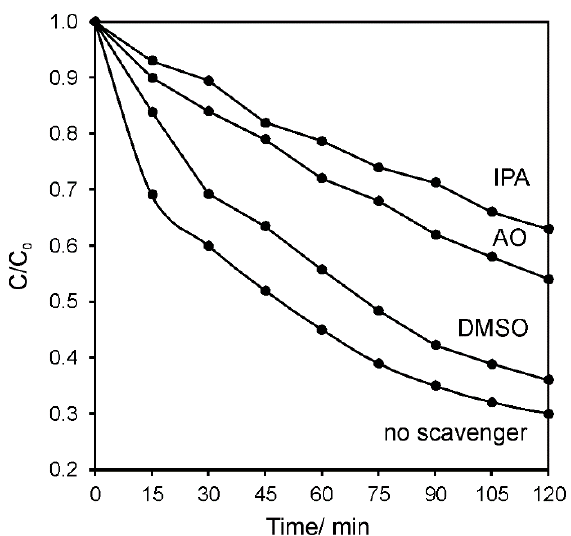
Figure 11. Photocatalytic degradation of RhB in the presence of the NiAl 2 O 4 /GQDs composite under simulated solar light irradiation without and in the presence of scavengers: ammonium oxalate (AO), isopropyl alcohol (IPA) and dimethyl sulfoxide (DMSO) used to capture holes, hydroxyl radicals and electrons, respectively.